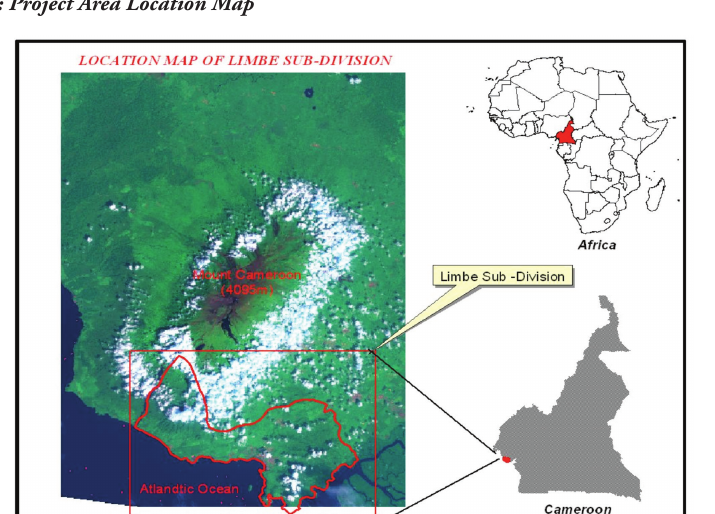
Figure 1: Project Area Location